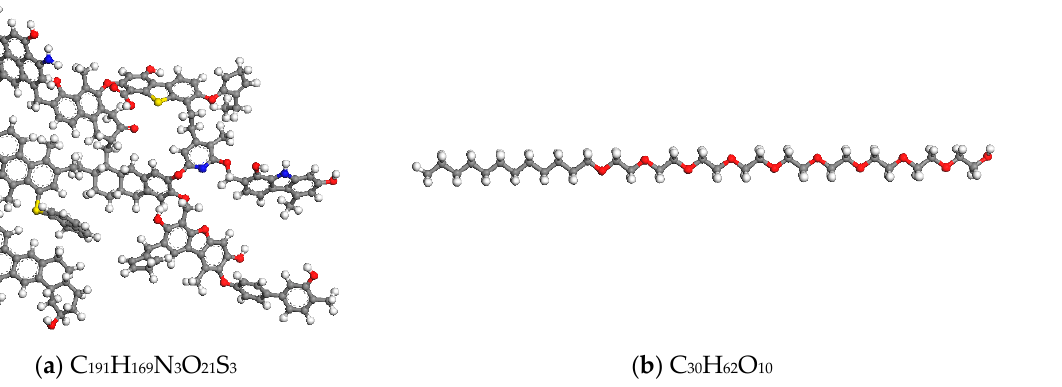
Figure 2. Molecular models: ( a ) bituminous coal; ( b ) AEO-9. The red, grey, white, yellow, and blue balls represent O, C, H, S, and N, respectively.